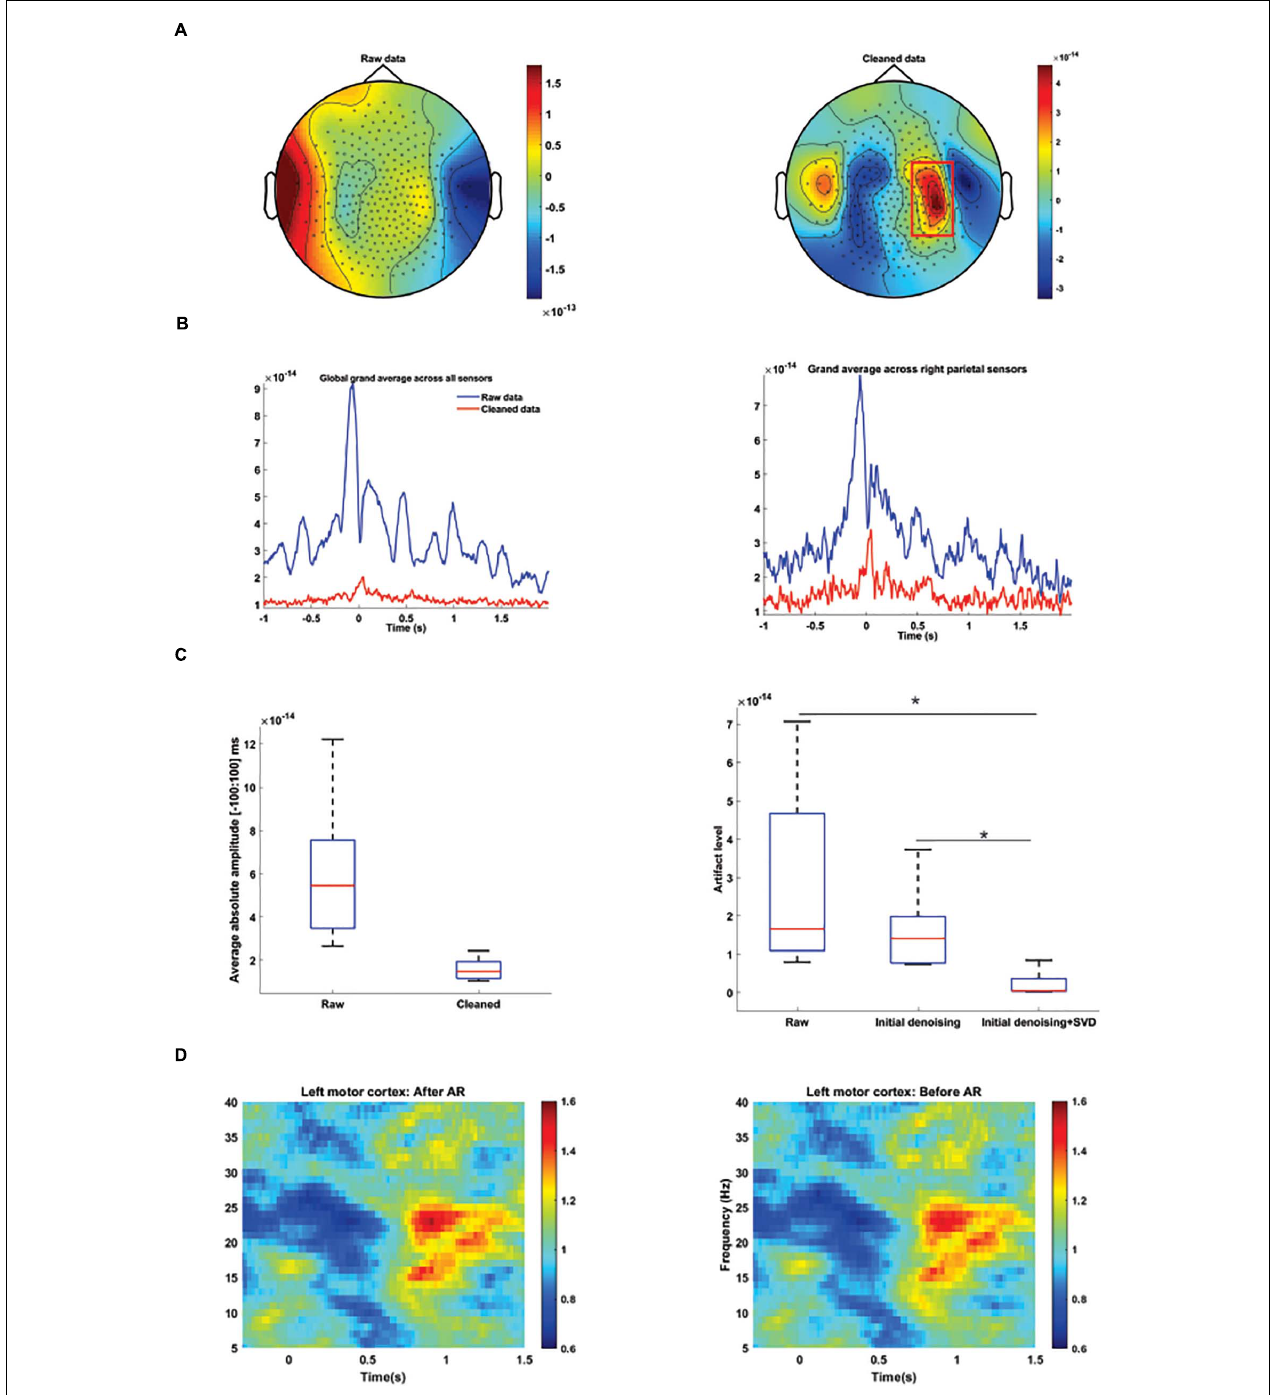
FIGURE 7 | MEG artifact rejection. (A) Average topographic distribution of MEG amplitude between 40 and 50 ms for raw data (left column) and after cleaning data by our proposed method (right column). M100 activity was masked before artifact rejection by speech related artifact. Color codes MEG amplitudes. (B) Absolute grand average of the time-series from all MEG sensors (left column) and sensors above the right parietal area (right column) from all the participants before (blue) and after (red) artifact rejection. Selected sensors are designated by a red rectangular. (C) Boxplots (left panel) showing the distribution of the average values of MEG amplitude between –100 and 100 ms across participants for raw and cleaned data. Right panel boxplots illustrate the distribution of artifact level after data cleaning by different approaches. Our proposed method could significantly remove artifacts from MEG data in comparison to other methods. Significant p -values (after t -test analysis) are indicated. * p < 0.01. (D) Time-frequency spectrograms of MEG sensors located above the left motor cortex before (left panel) and after (right panel) artifact rejection. Beta suppression and rebound were clearly observable before and after artifact rejection. Color codes relative changes. Time point 0 s marks syllable pronunciation